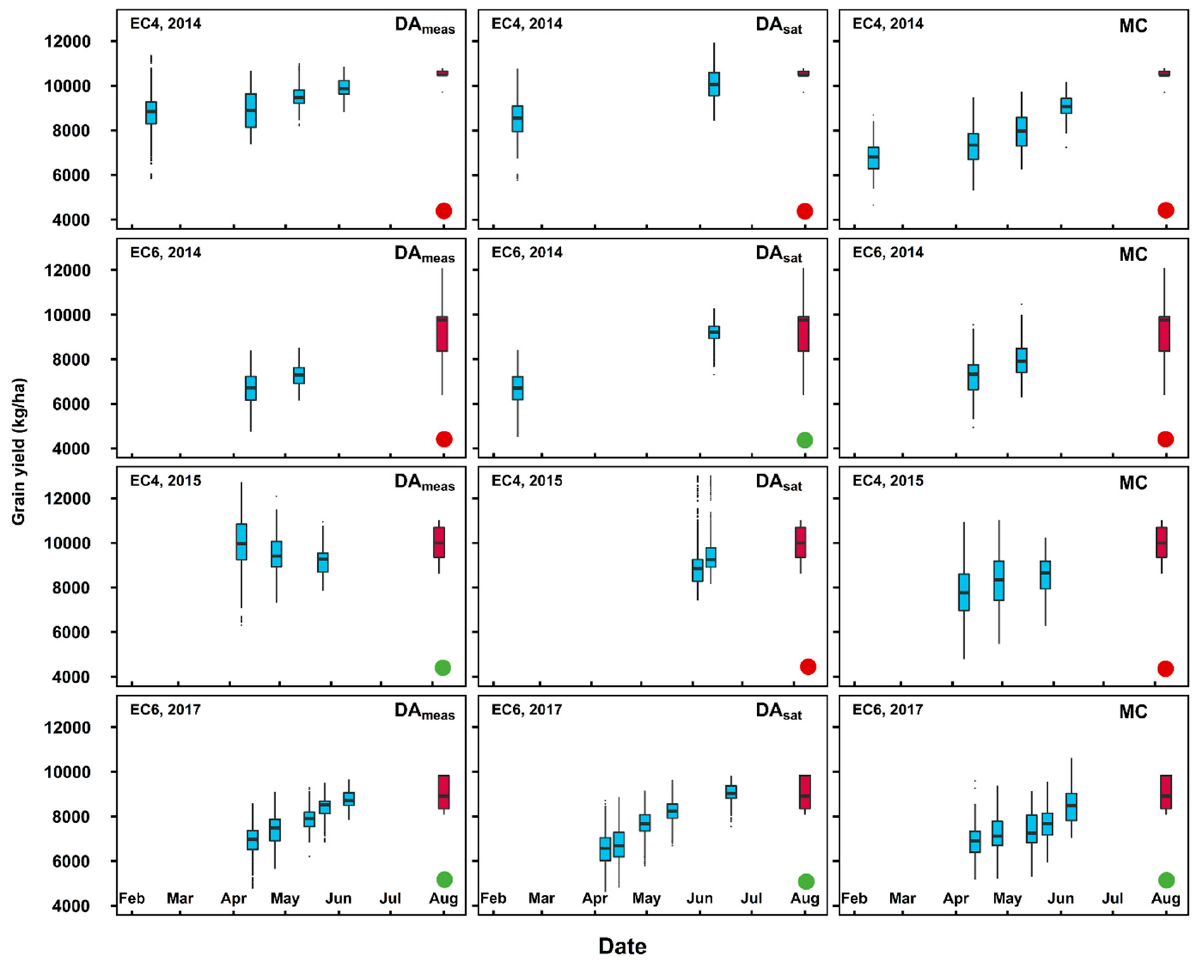
Figure 6. Wheat grain yield prediction with data from Swabian Jura (SJ). Left column : DA meas (data assimilation based on LAI measured in-situ), middle column : DA sat (data assimilation based on satellite observations of LAI) and right column : MC (Monte Carlo simulation). The red boxes show the measured yield. The dates of the blue boxes in DA meas and MC subplots show the dates of in-site measured LAI, and the dates of the blue boxes in DA sat subplots show the dates of remote sensing LAI. The dates of the red boxes correspond to the harvest date. Subplots with green circles signify that the median prediction of the last assimilation step is within the interquartile range of the measurements, otherwise, sublopts have red circles.